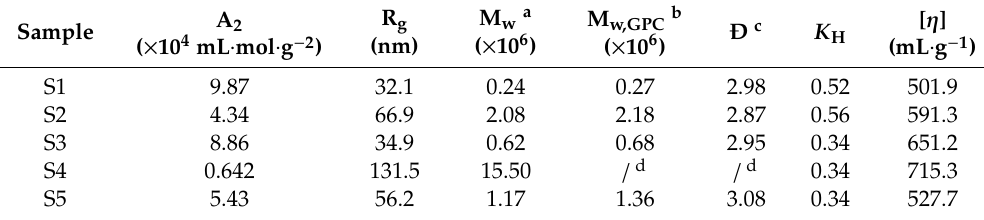
Table 3. Structural parameters of the five polymers in mixed formamide / water (1:1) at 25 ◦ C.